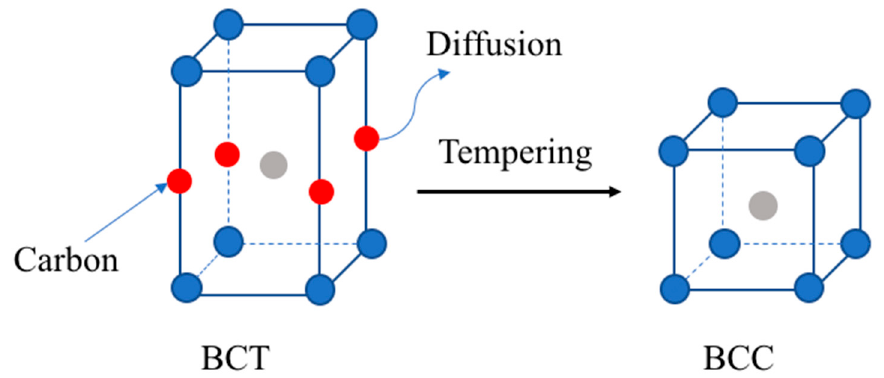
Figure 7. Schematic of changes in crystal structure of martensite during tempering (BCT: body-centered tetragonal; BCC: body-centered